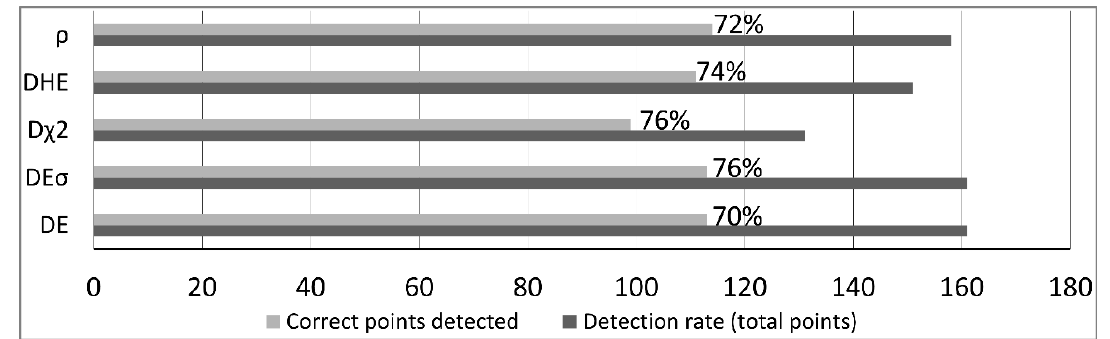
Figure 4. Detection rate and correct and incorrect points using the following metrics: Euclidean (D E ), standardized Euclidean (D E σ ), chi-square (D χ 2 ), and Hellinger (D HE ).